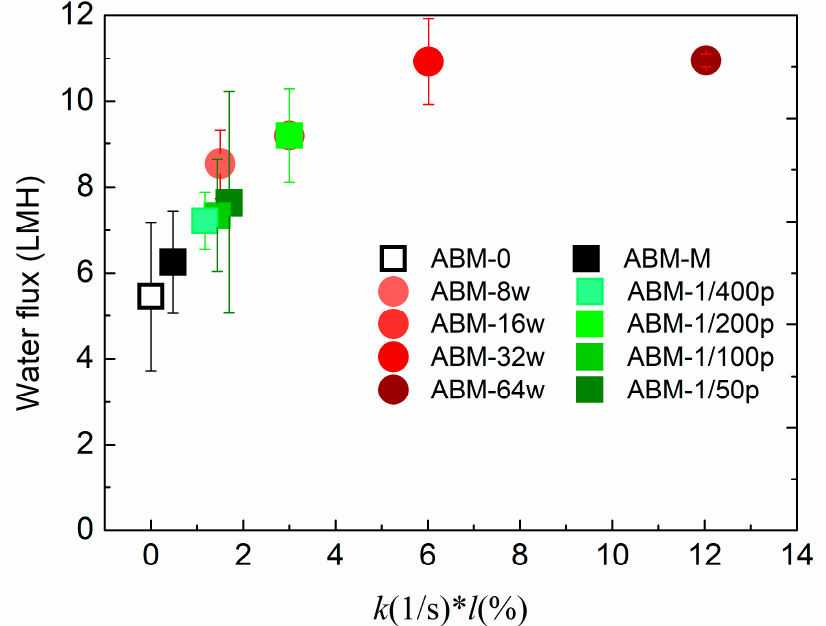
Figure 4. The correlation of water flux of ABMs with the lumped parameter, k*l , where k, l indicate rate constant and loading concentration, respectively. Note that ABM-16w is identical to ABM-1/200p since they share the same protein-to-lipid ratio and proteoliposome concentration. k values were averaged based on the results of 5 independent measurements.